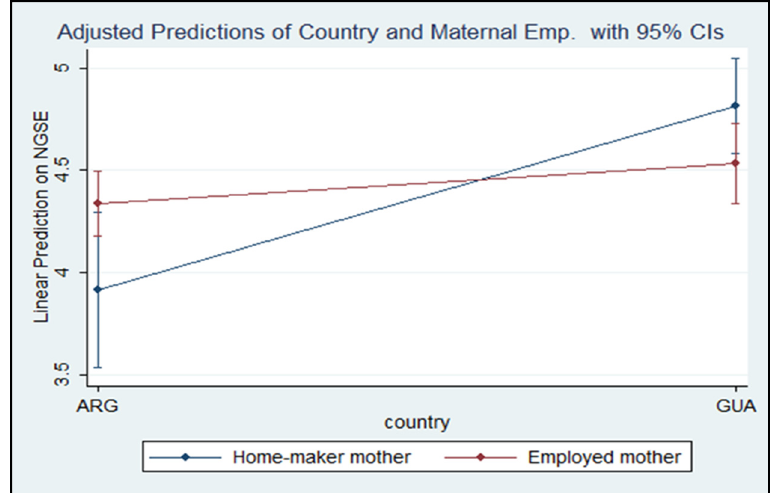
Figure 1. Self-efficacy differences in country and mother’s employment status. Note: the figure refers to values at 95% confidence level (CI). In the ordinate axis the predicted value of the New General Self-Efficacy scale (NGSE). Referring to the countries ARG is Argentina and GUA is Guatemala.